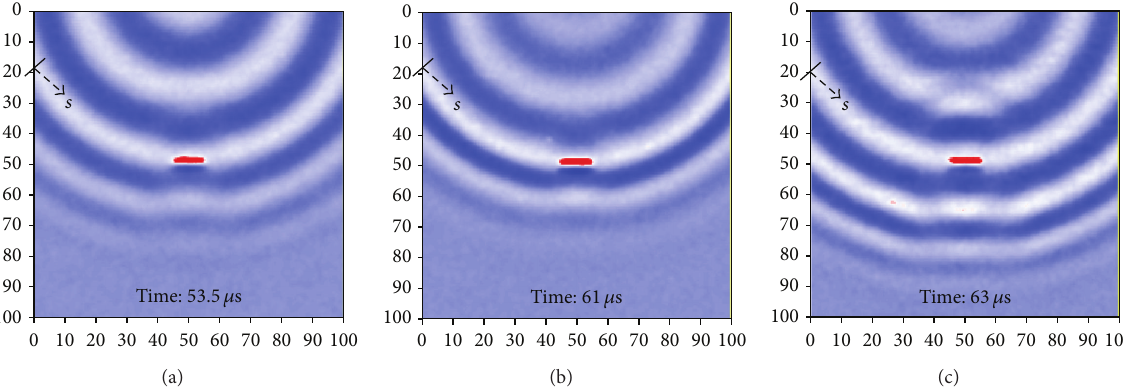
Figure 8: Ultrasonic wave fields obtained by the repeat scanning method (10 times): (a) free plate, (b) immersed plate in water ( 𝐷 = 10 mm), and (c) immersed plate in glycerin ( 𝐷 = 10 mm).